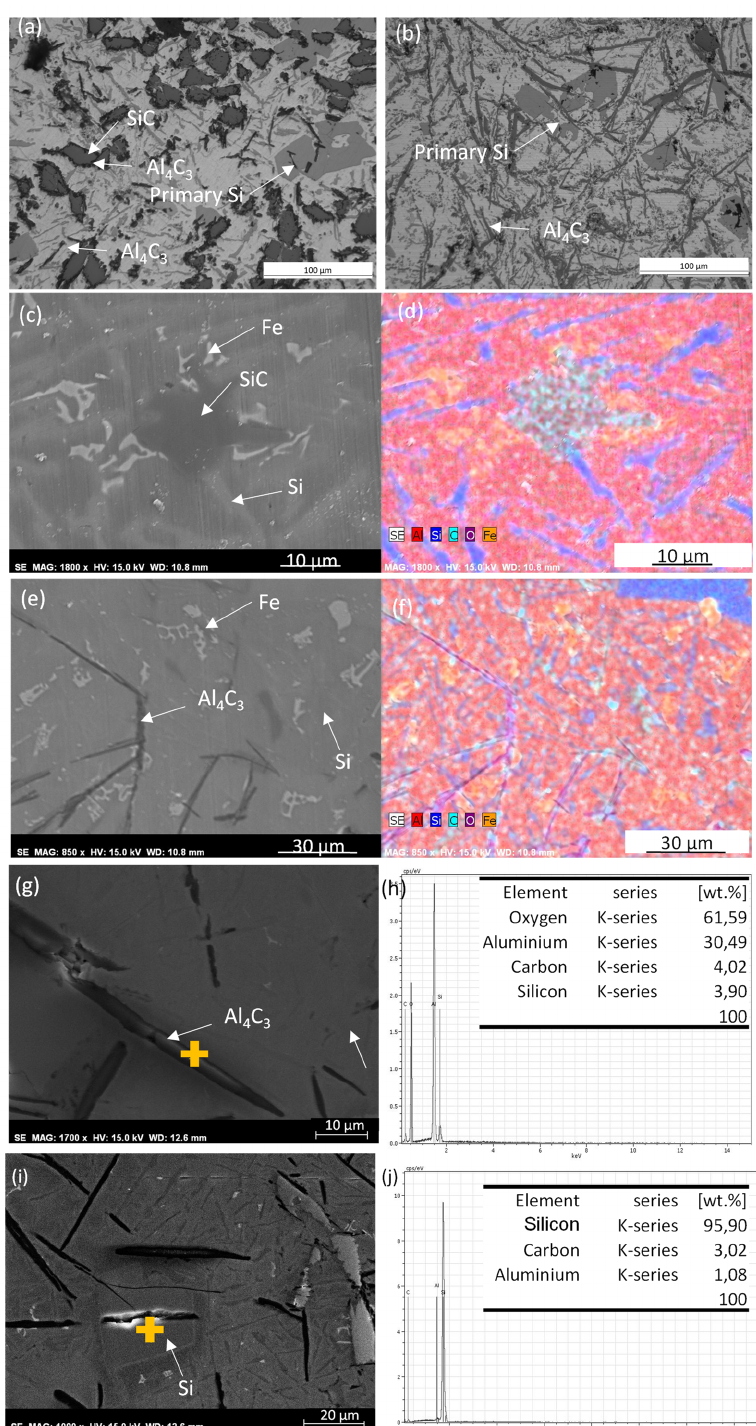
Figure 4. Al / SiCp microstructure ( a ) OM image made on the middle of the cross-section; ( b ) OM image made on the bottom of the cross-section; ( c ) Detail of partially dissolved SiC; ( d ) EDS element map of surface shown in ( c ) color code: aluminum in red, silicon in blue, carbon in cyan, oxygen in purple, and iron in yellow; ( e ) Detail of Al 4 C 3 needles; ( f ) EDS element map of surface shown in ( e ) color code: aluminum in red, silicon in blue, carbon in cyan, oxygen in purple, and iron in yellow; ( g ) Detail of Al 4 C 3 needles; ( h ) EDS analysis made on the surface shown in ( g ); ( i ) Detail of primary Si; ( j ) EDS analysis made on the surface shown in ( i